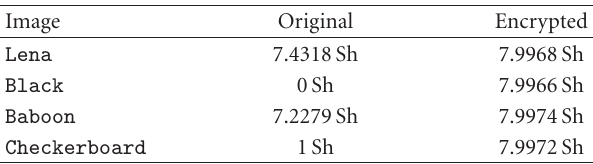
Table 4: Comparison of entropy values of original images and their encrypted version.